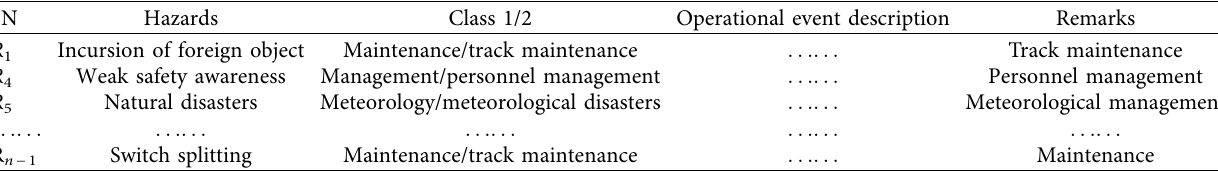
Table 4: Actual operation data after acquisition and preprocessing.